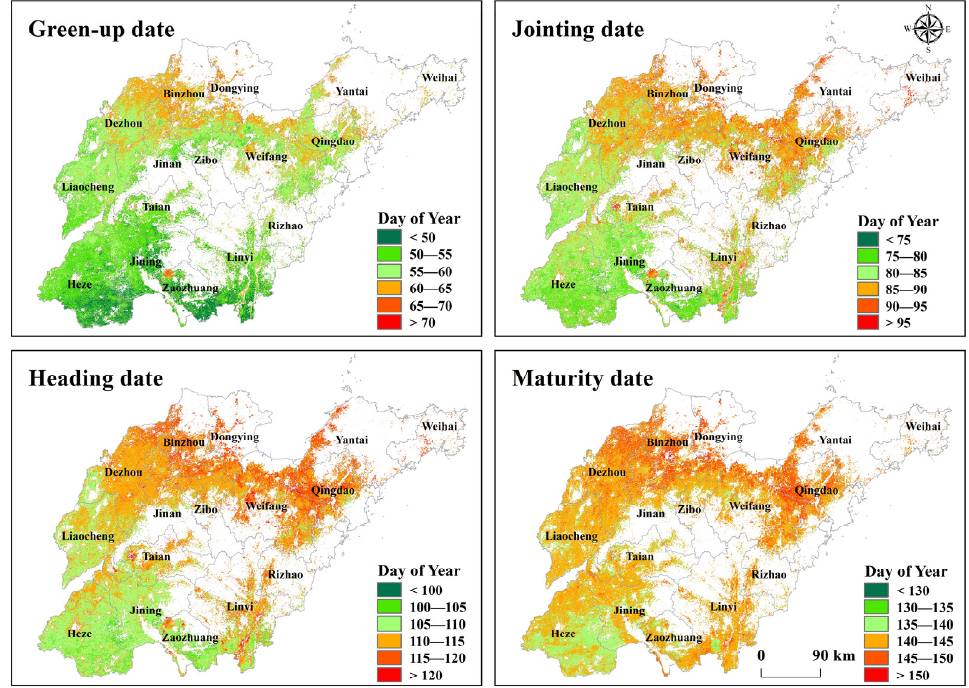
Figure 5. Spatial pattern of multi-year average green-up date, jointing date, heading date, and maturity date of winter wheat during 2003–2019 in Shandong Province.